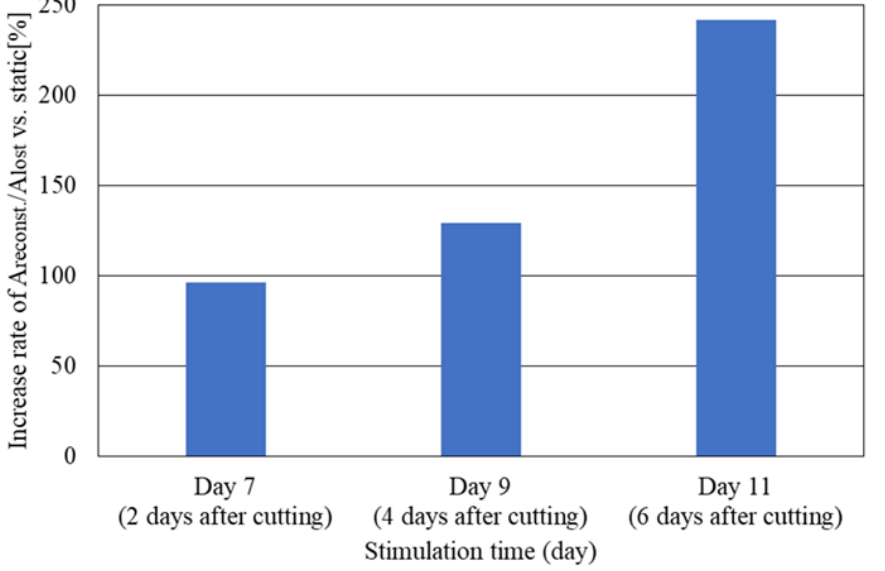
Figure 8. Relationship between the increased rate of reconstruction efficiency Areconst./Alost and the culture time. Y -axis is normalized reconstruction efficiency (stimulation/static) calculated from the results shown in Figure 7.